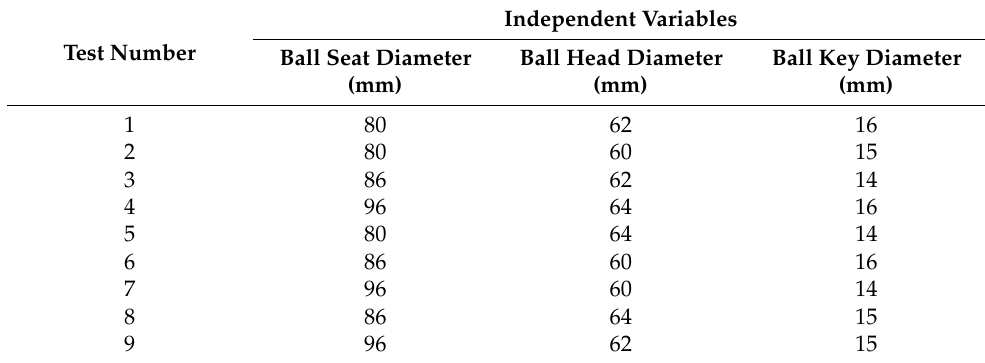
Table 2. Orthogonal test scheme design